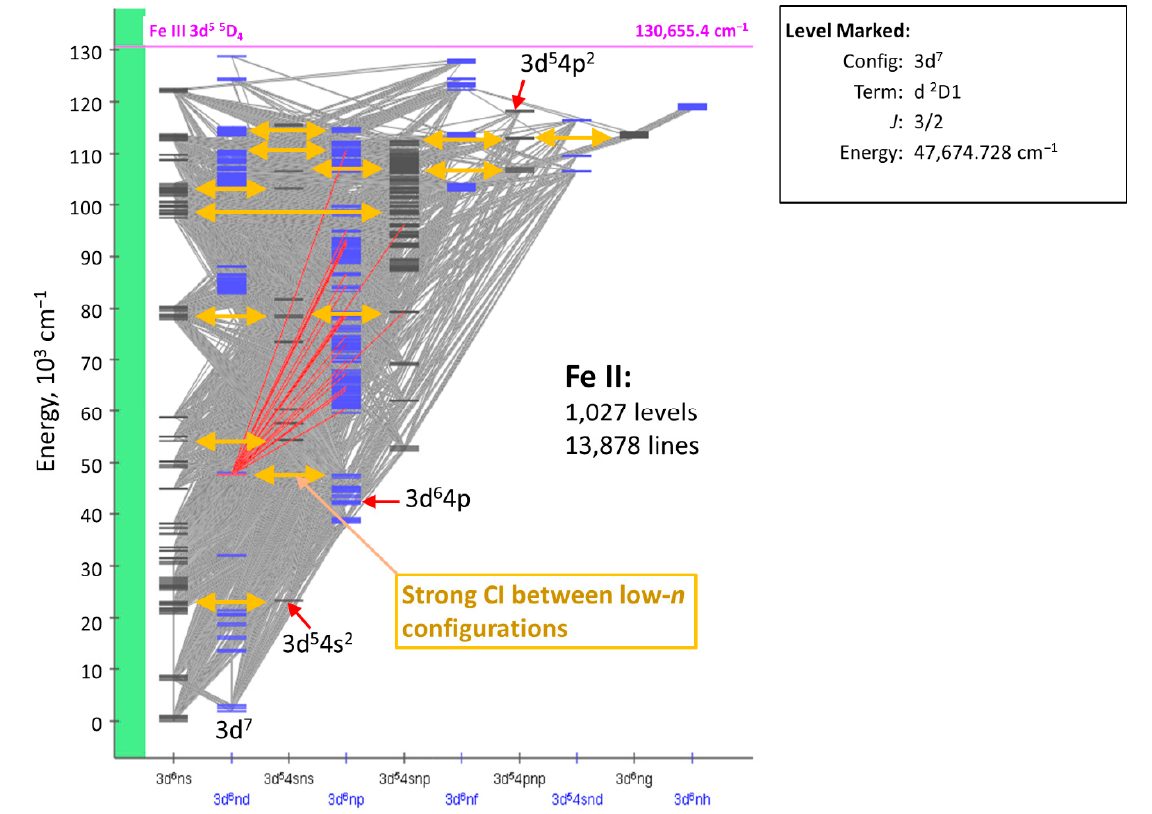
Figure 5. Grotrian diagram of the Fe II spectrum [20]. The yellow horizontal double-arrows indicate strong configuration interactions.